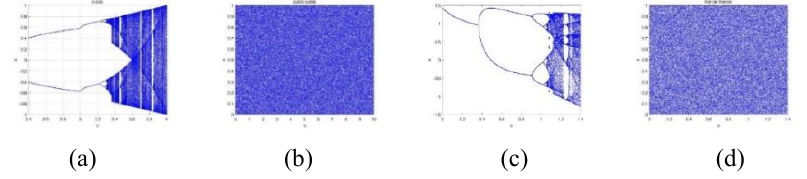
Fig. 1. The bifurcation diagram of the (a) Cubic map. (b) Improved Cubic map. (c) Henon map. (d) Improved Henon